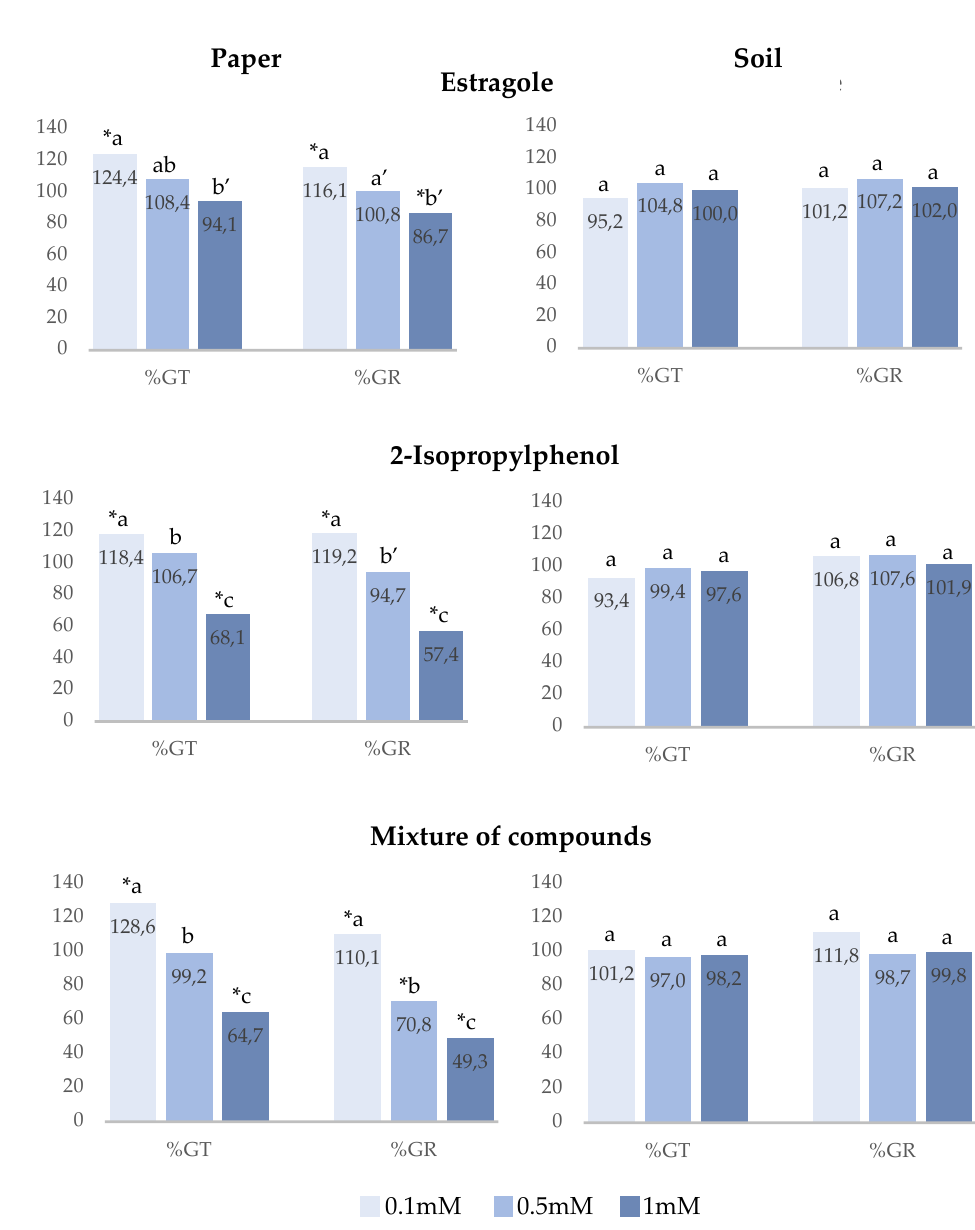
Figure 1. Effect of different concentrations of Estragole and 2-Isopropylphenol on Allium cepa germination percentage (%GT) and germination rate (%GR), expressed as the percentage relative to the control (Control value: 100%). Four replicates of each treatment were performed ( n = 4 × 50 = 200 seeds in total for each solution). * Significantly different from the controls. ’ Significantly different from the mixture of compounds. a, b, c: differences in small letters indicate significant differences between concentrations of the same index and for each treatment. p < 0.05 (Mann–Whitney